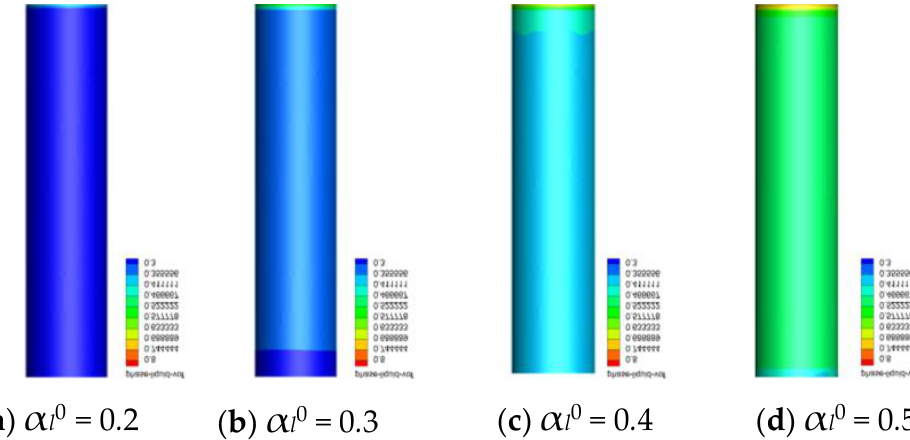
Figure 12. Distribution of the liquid volume fraction at t = 5 s, where α l 0 = 0.2, 0.3, 0.4, and 0.5. In addition, Figure 14 shows the time history of the volume fraction of the liquid, where the initial volume fractions of the liquid are different, namely, α l 0 = 0.2, 0.3, 0.4, and 0.5. It is observed that the volume fraction of the liquid increases with time almost linearly. The volume fraction of the liquid is composed of two parts, the initial part and